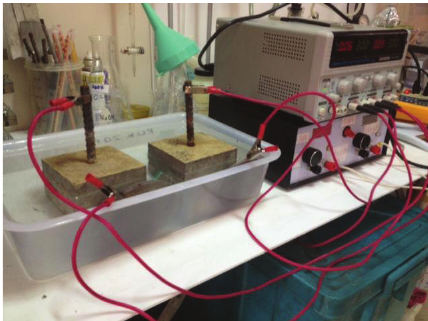
Figure 3: The accelerated corrosion test